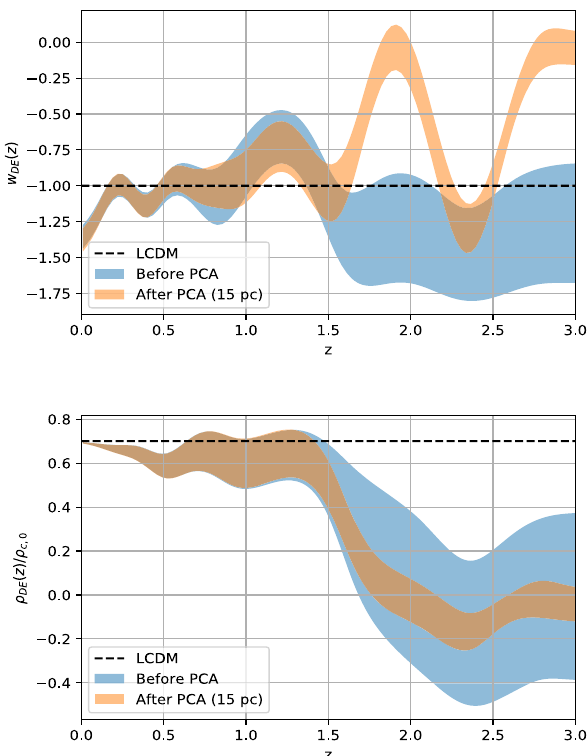
Fig. 7 Applying the principal component technique to our reconstruc- tions of the EoS and the energy density with 20 bins. By eliminating 5 PCs (which add up to about 5% of the total variance for each recon- struction)weobtaintheorangefigureswithslightlyoverestimatederrors localized in z > 1 .